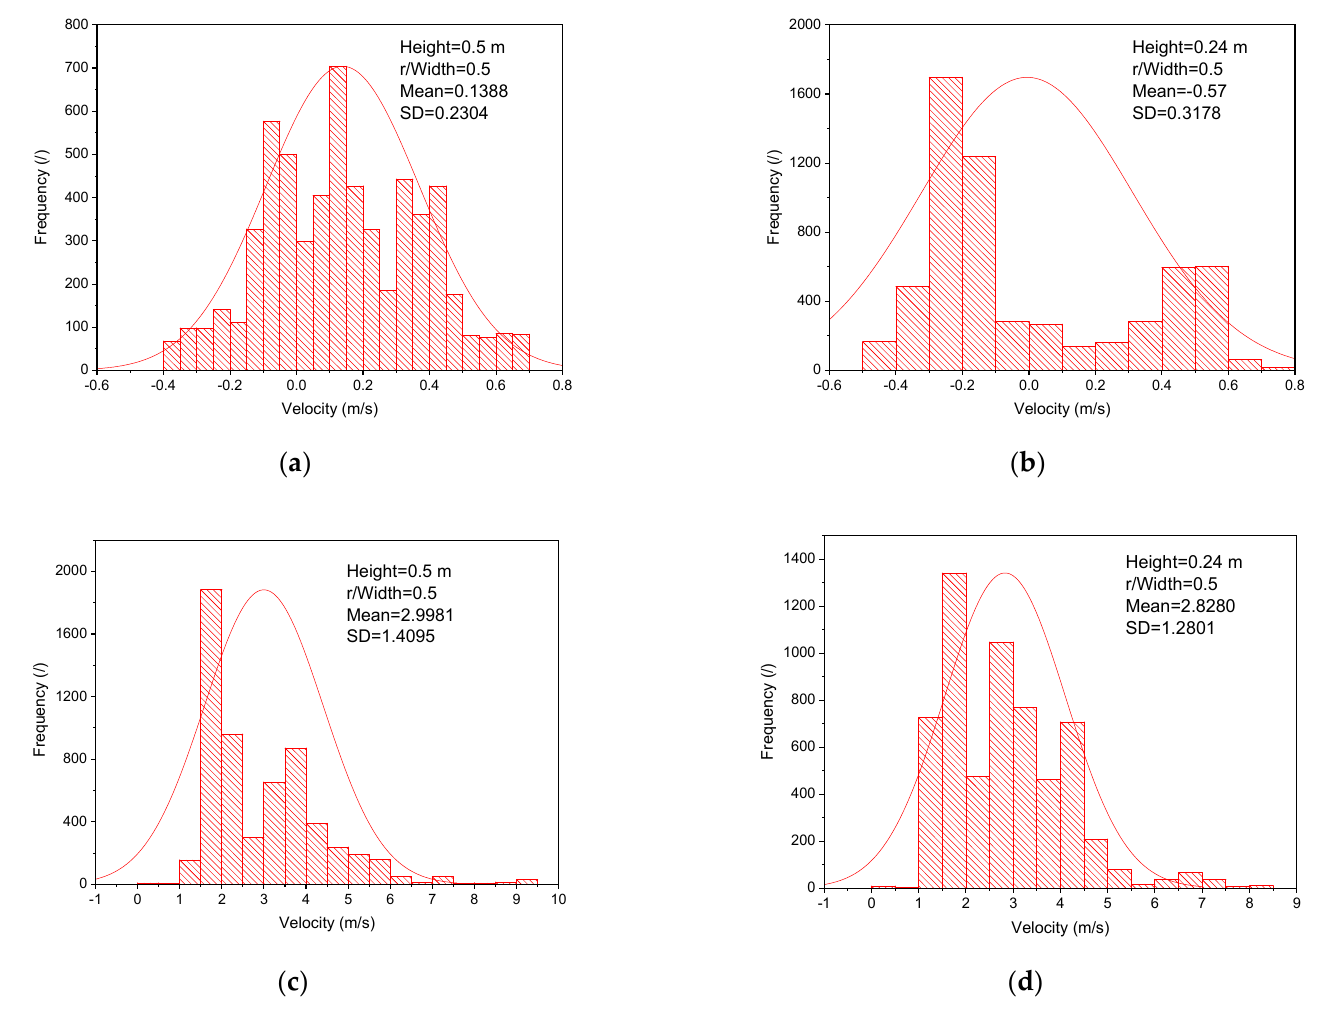
Figure 6. Histograms of center axial and lateral velocities of EG particles at the height of 0.24 m and 0.5 m, r/Width = 0.5, ρ p = 800 kg/m 3 . ( a ) lateral velocity, 0.5 m; ( b ) lateral velocity, 0.24 m; ( c ) axial velocity, 0.5 m; ( d ) axial velocity, 0.24 m.